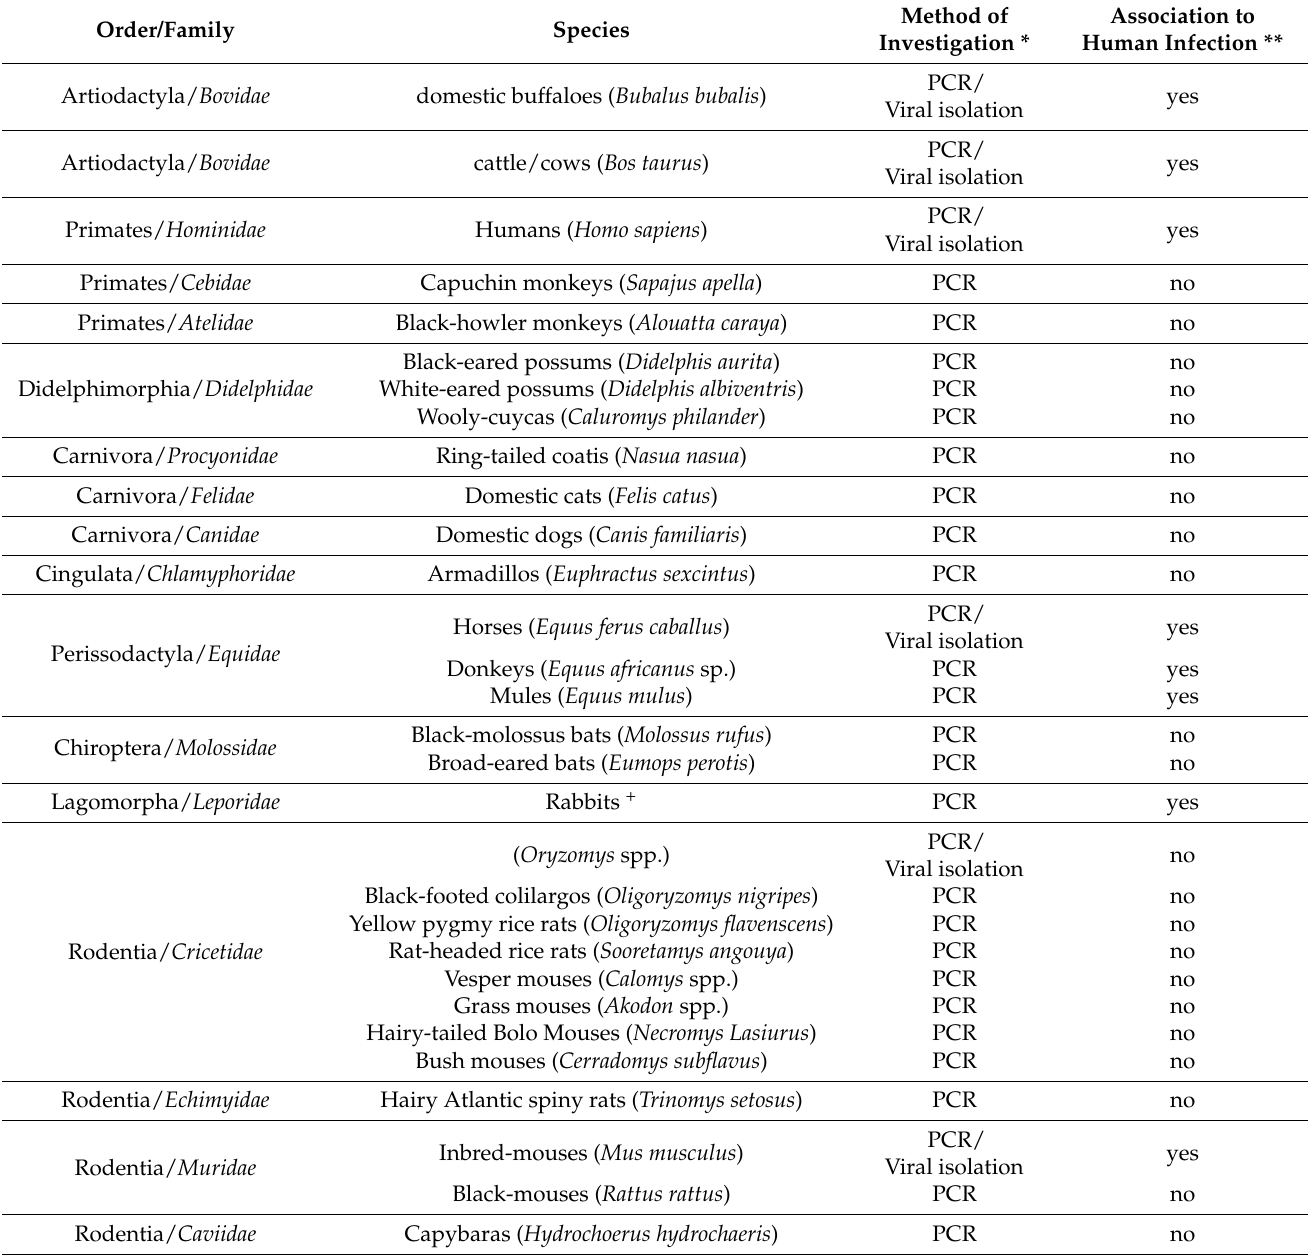
Table 3. Hosts and susceptible animals to vaccinia and vaccinia-like viruses